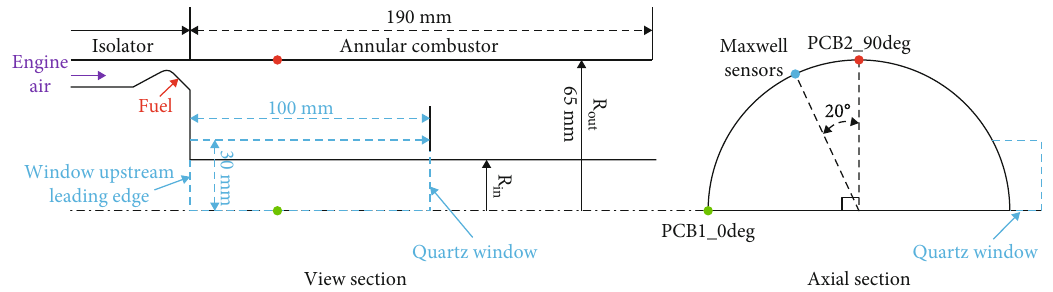
Figure 1: Schematic diagrams of test section and sensor